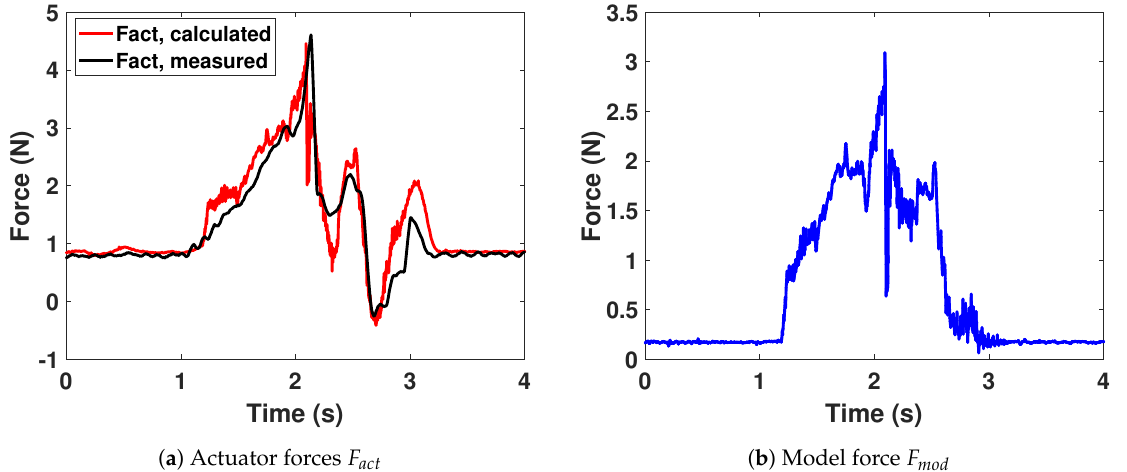
Figure 21. Measured and targeted forces during validation with the piano action model.